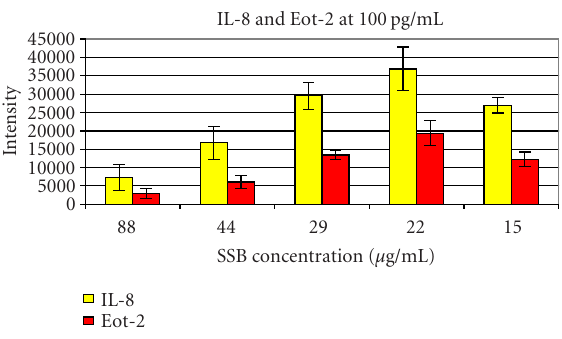
Figure 3. Titration of SSB in the RCA reaction mixtures. Cy- tokine IL-8 and Eot-2 at 100 pg/mL were